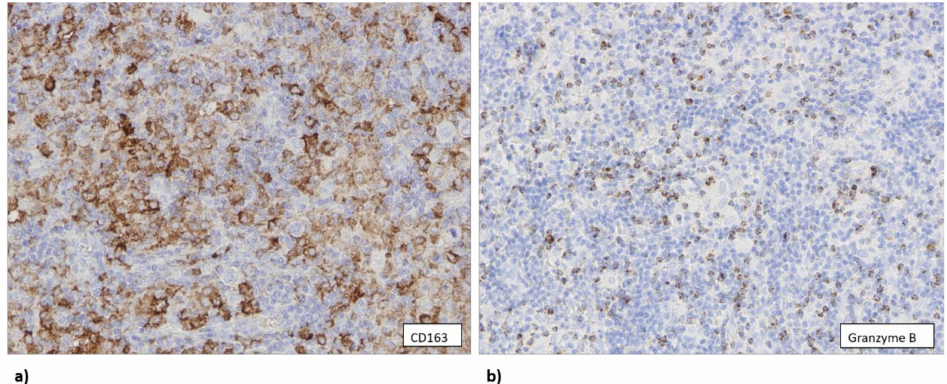
Figure 3. ( a ) Sample with a high number of CD163+ cells (400 × total magnification). ( b ) The same sample as on panel ( a ) that also contained a high number of expressing granzyme B (400 × total magnification).